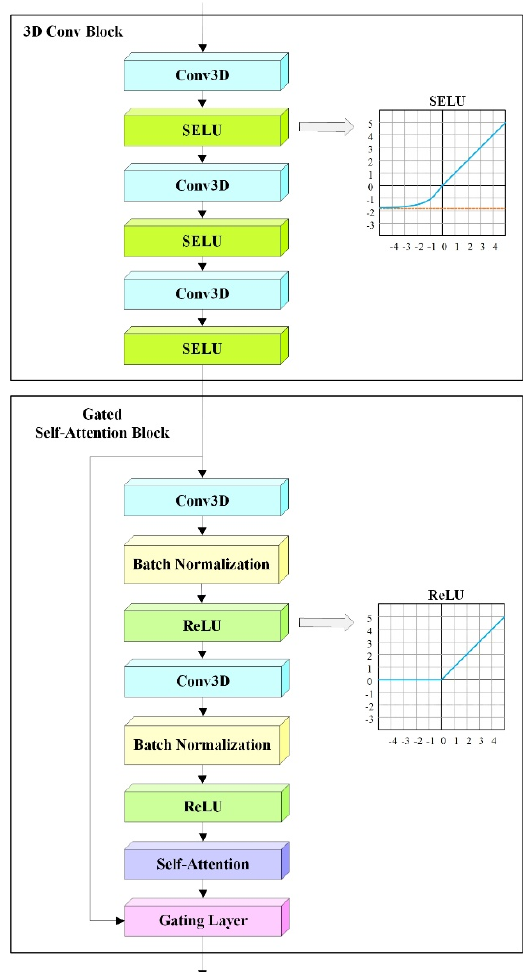
Figure 4. Architecture of the 3D convolutional gated self-attention deep neural network.